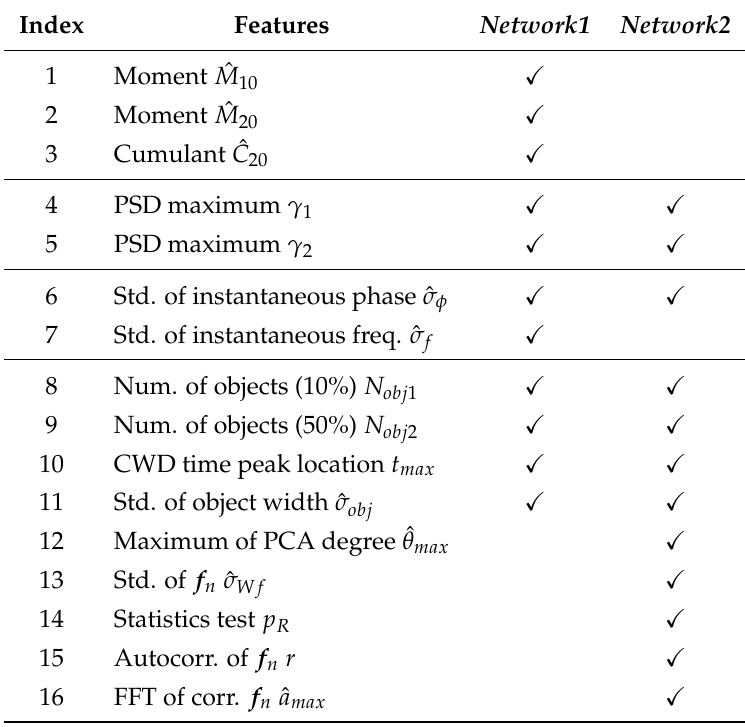
Table 1. List of features selected for the